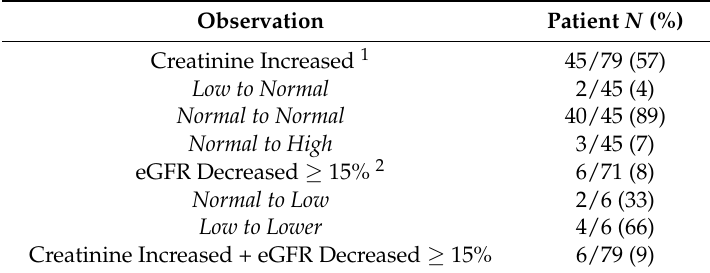
Table 3. Changes in participant renal function.